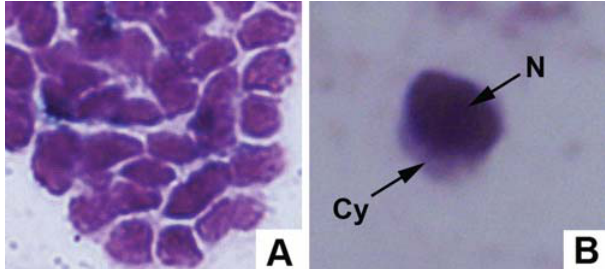
Figure 1. Light-microscopic views of the lymphocyte-like cells in the amphioxus. (A) Many lymphocyte-like cells in the gills. Magnification 400. (B) The cells of the amphioxus gills contained large, darkly stained nuclei and the thin rim of cytoplasm. Magnification 1000, Wright stained.